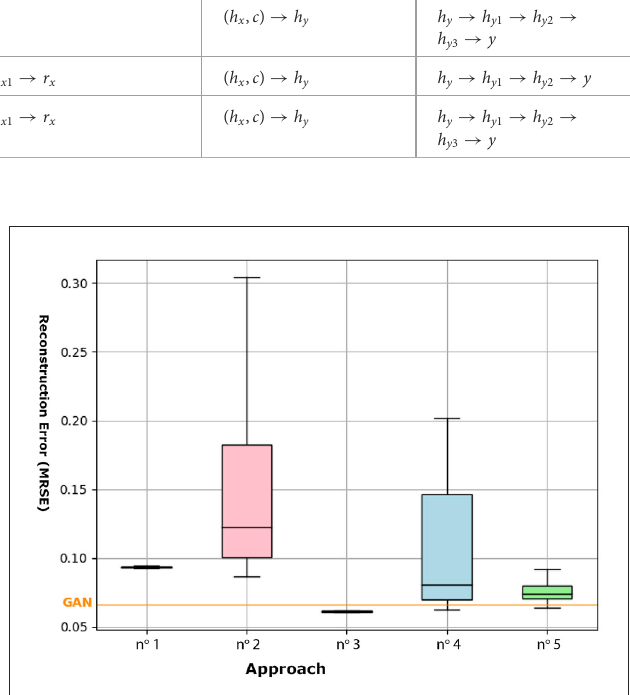
FIGURE8 Box plot summarizing the error rates obtained by approaches n. o 1 to 5 on the in vitro database. The orange horizontal line indicates the performance of the GAN (NRMSE =